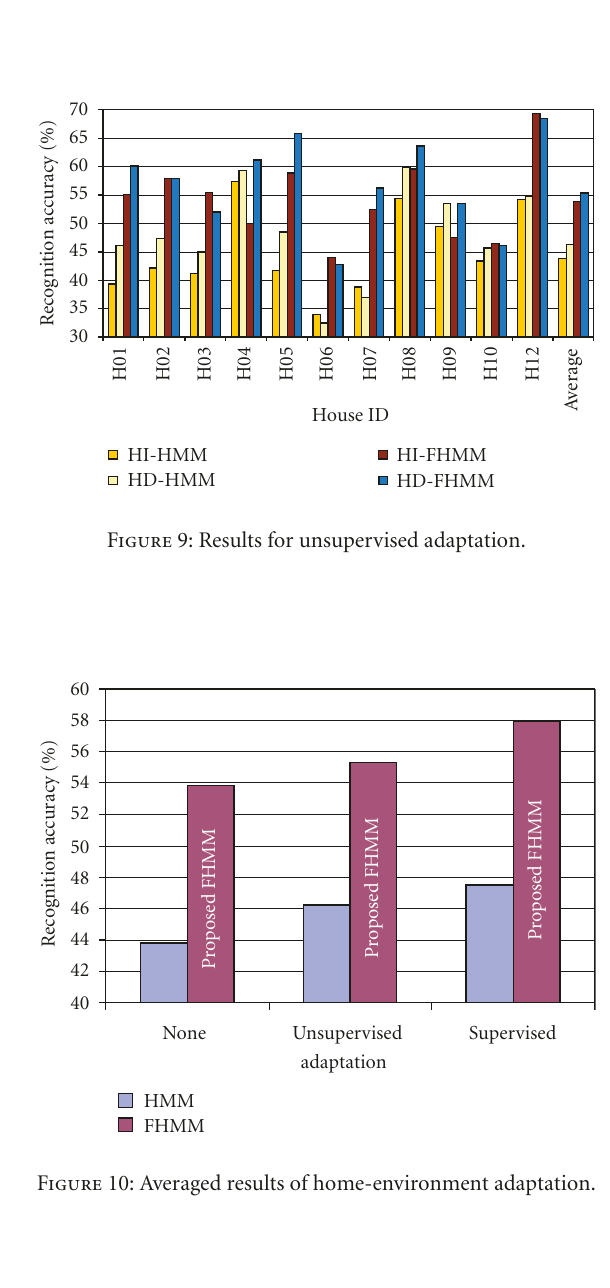
Figure 8: Results for supervised home-environment adaptation.